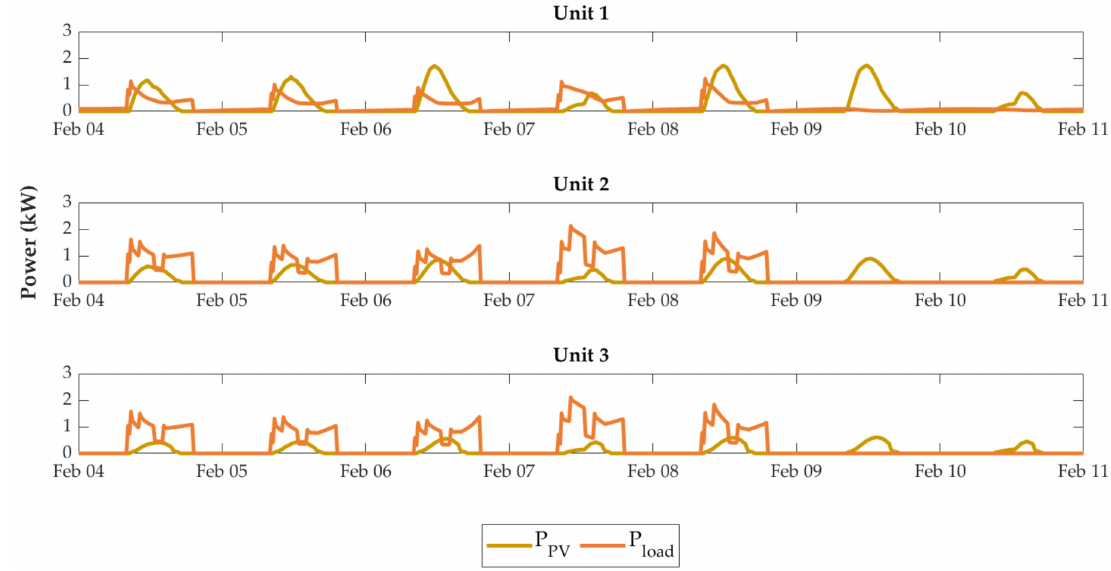
Figure 8. PV production and consumption power profiles of a typical winter week.